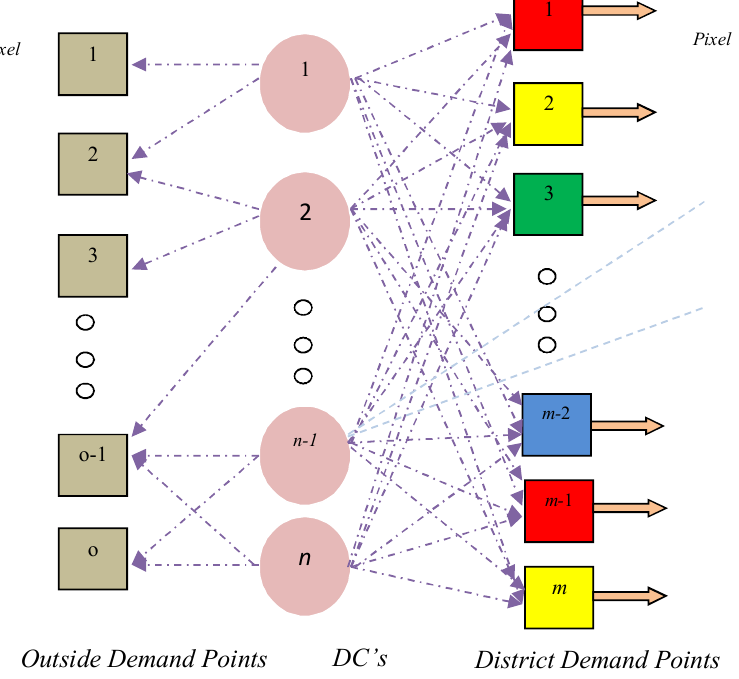
Fig. 1 . Relief chain